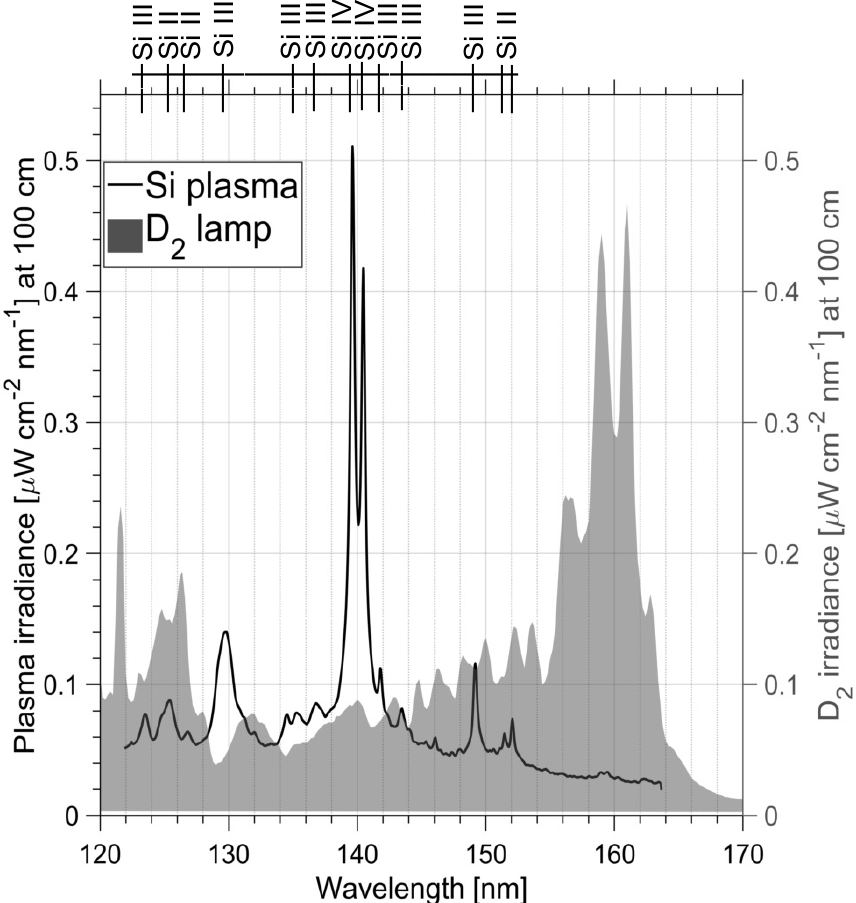
Figure 1. Comparison of the spectral irradiance of the standard Deuterium (D 2 ) lamp (gray shaded area, right-hand scale) with a typical recorded calibrated spectral irradiance of a Si plasma at a distance of 100 cm from the target over the ≈ 123–164 nm wavelength region generated by 1.064 µ m laser, 10 ns FWHM pulses at 100 Hz repetition rates (black line, left-hand scale). The laser irradiance was ≈ 2.5 × 10 11 W cm − 2 (the laser energy ≈ 230 mJ). The strong Si spectral lines are identified using the NIST atomic database [22] as listed in Table 1. Table 1. The observed Si spectral lines (Figure 1) according to the NIST database [22].